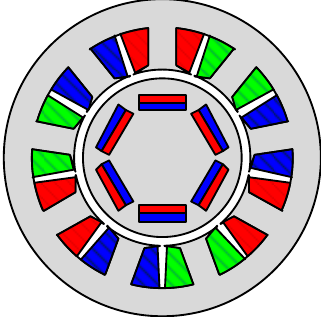
Figure 1. Simplified design of IPMSM.